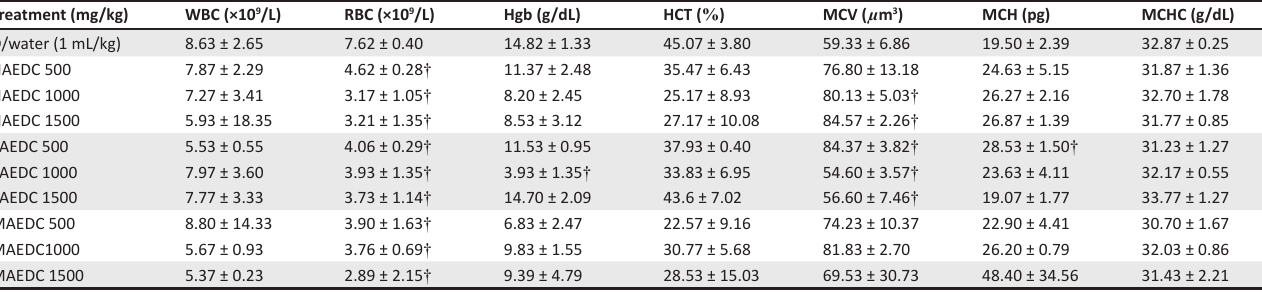
TABLE 2: Effects of oral administration of n -hexane, ethyl acetate and methanol extracts of Daucus carota aerial part on the haematological parameters of Wistar rats after 28 days. Treatment (mg/kg)